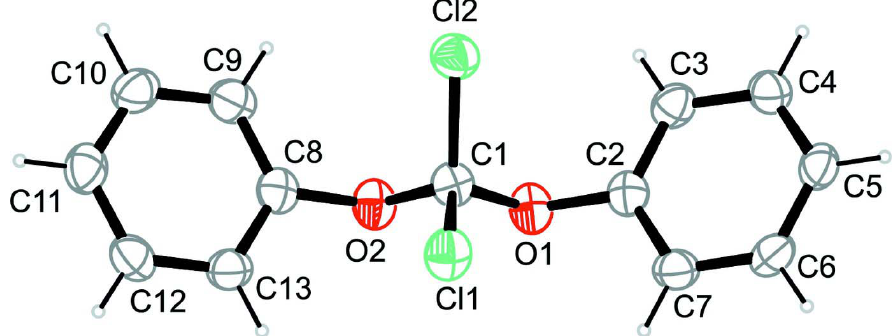
The molecular structure of (I), with atom labels and anisotropic displacement ellipsoids (drawn at 50% probability level) for non-H